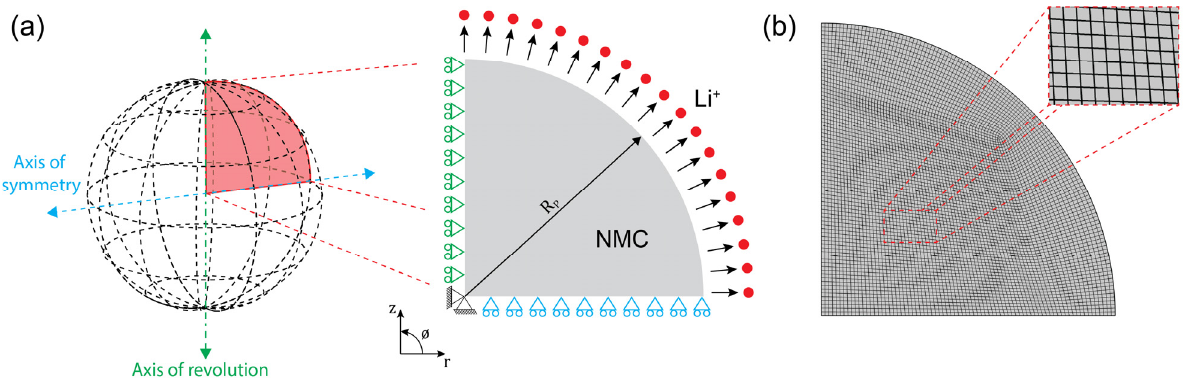
Figure 1. ( a ) Schematic representation and ( b ) spatial discretization of an axisymmetric model system used to perform numerical simulations.